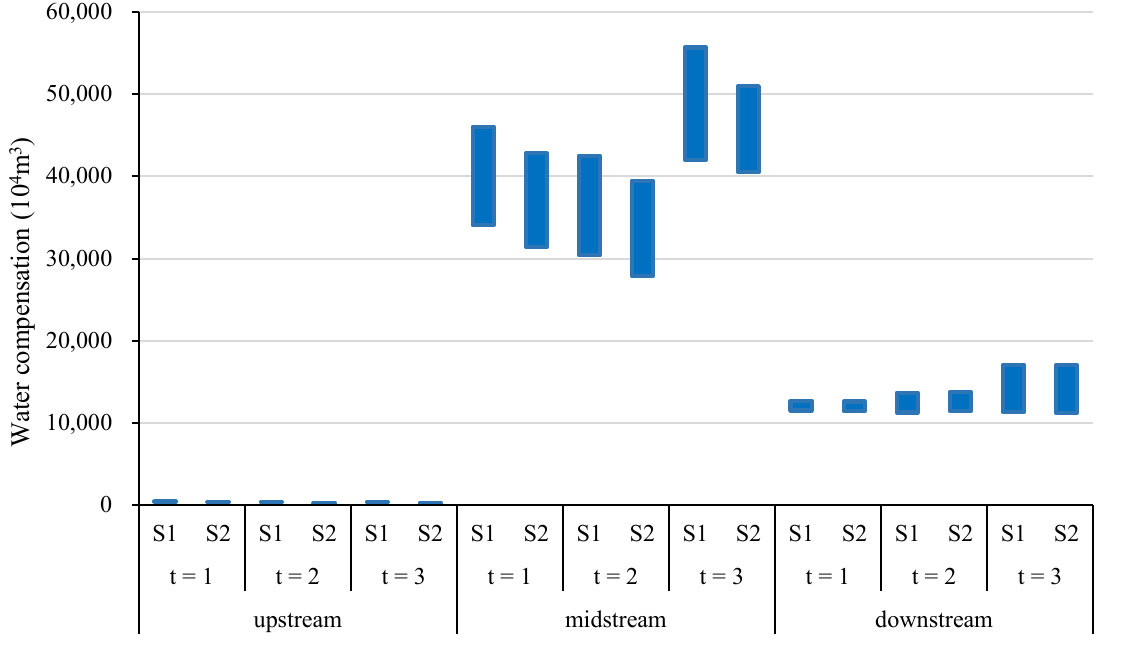
Figure 16. Water compensation in the Fenhe River Basin under different scenarios.